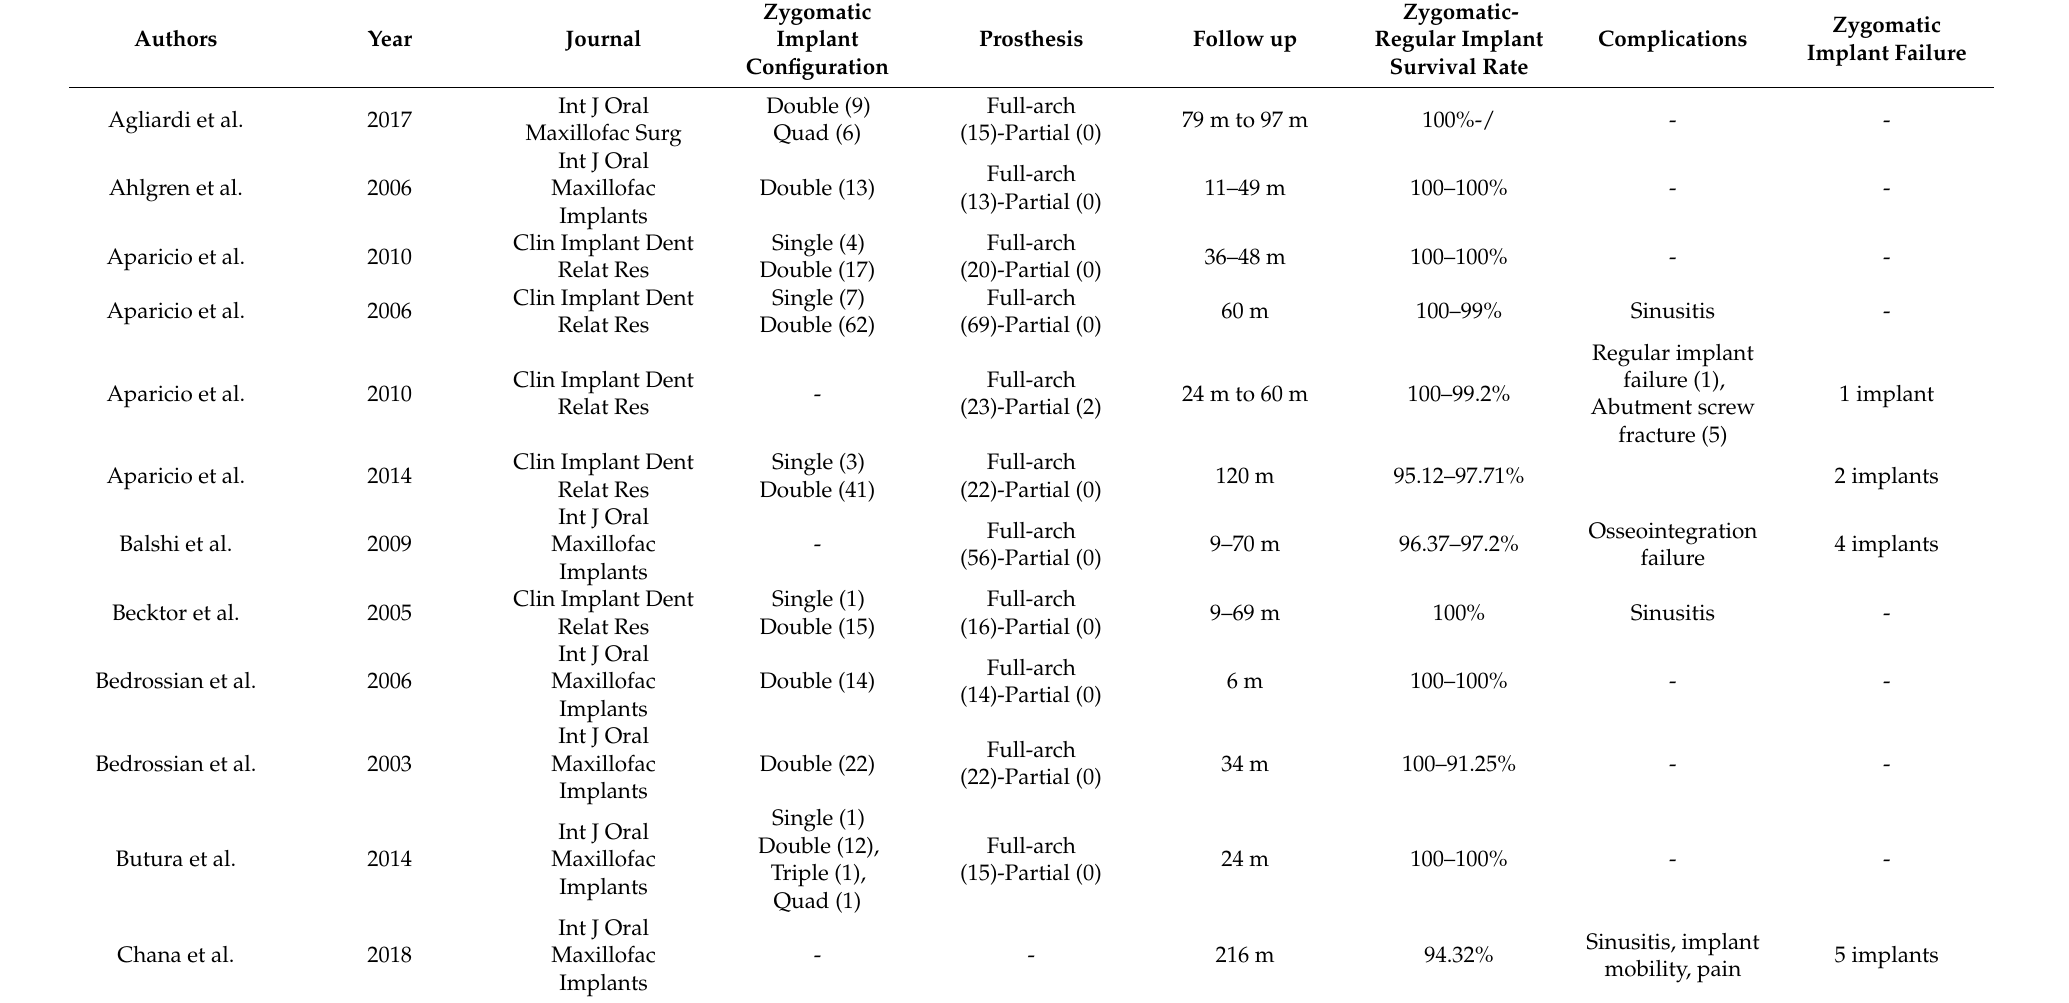
Table 3. Summary table of the papers included for the qualitative